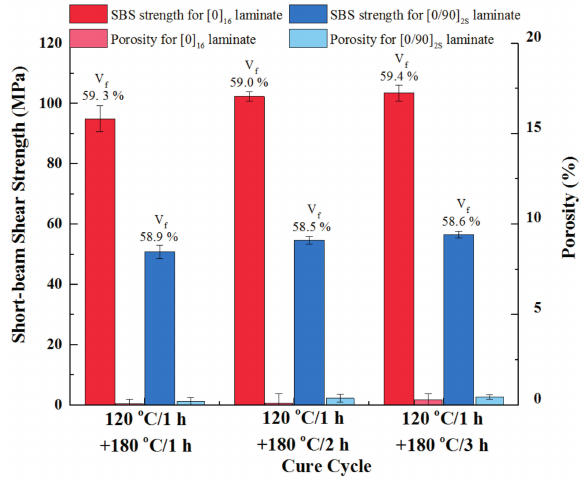
Figure 9. Effect of post-cure time on mechanical properties and void content of laminates.